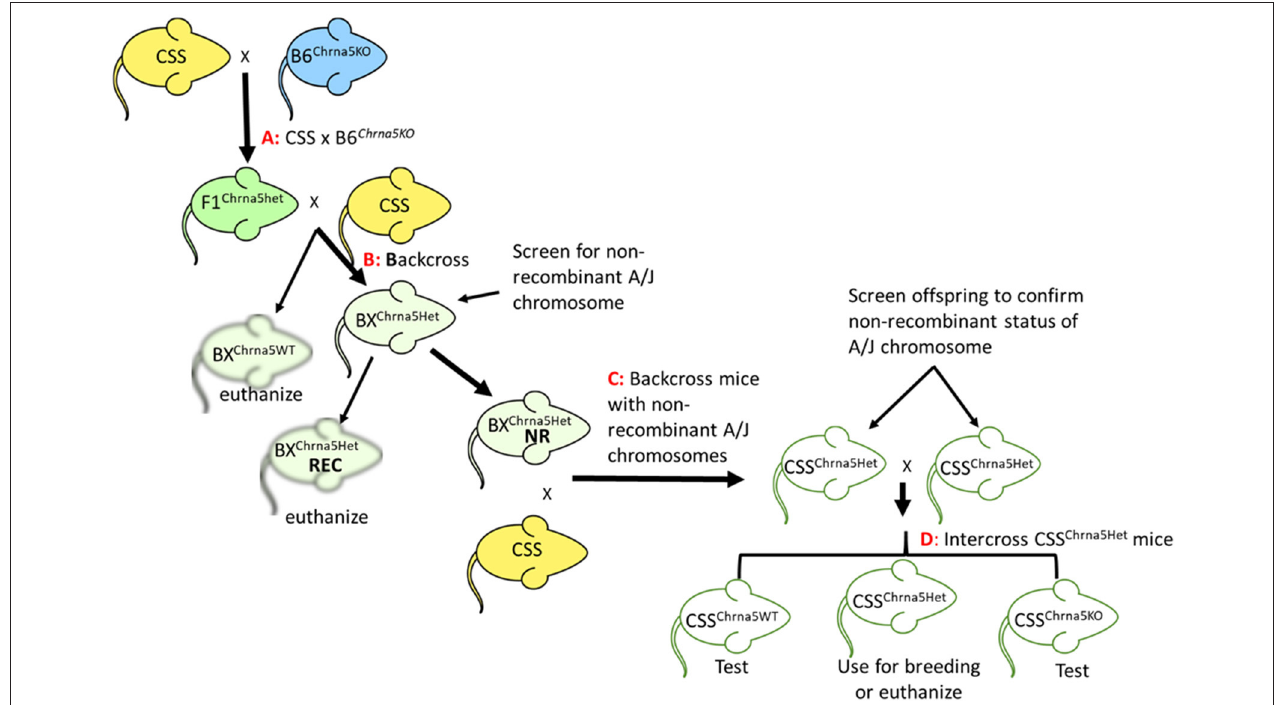
FIGURE 1 | Schematic of the breeding strategy used to generate CSS possessing the Chrna5 null mutation. (A) Cross between a parental CSS and Chrna5 KO mice on a B6 genetic background (B6 Chrna5 KO ). (B) Backcross of F1 mice heterozygous for the Chrna5 KO allele (F1 Chrna5 het ) generated by cross (A) to CSS parental strain. (C) Backcross offspring from backcross (B) to parental CSS. Only backcross offspring that were determined to be non-recombinant for the appropriate A/J chromosome (BX Chrna5 het NR) were used. Backcross animals that were recombinant for the appropriate A/J chromosome (BX Chrna5 het REC) were euthanized. (D) Intercross between littermates that possessed a non-recombinant A/J chromosome and were heterozygous for the Chrna5 KO allele (CSS Chrna5 het ). CSS mice WT for Chrna5 (CSS Chrna5 WT ) or homozygous for the Chrna5 KO allele (CSS Chrna5 KO ) resulting from intercross (D) were used for the two-bottle choice test.